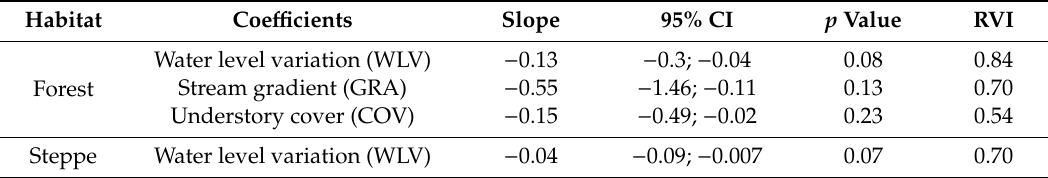
Table 5. Parameters and relative variable importance (RVI) of the best models selected for forest and steppe habitats to estimate the probability of lodge abandonment.